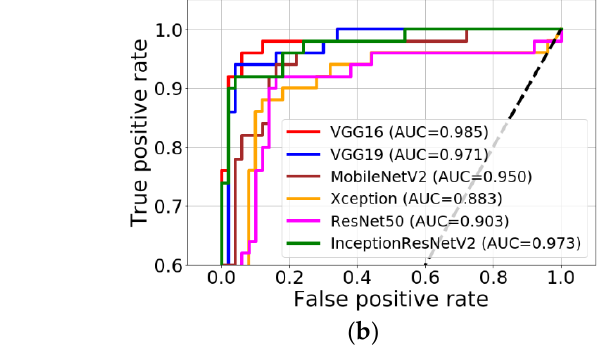
Figure 12. Classification results ( a ) and ROC curves and AUCs for the test set ( b ). Symbols used: V16 — VGG16, V19 — VGG19, MN — MobileNetV2, X — Xception, RN — ResNet50, and IRN — InceptionResNetV2.